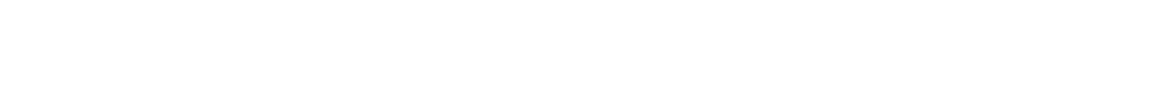
Frontiers in Psychology | Cognitive